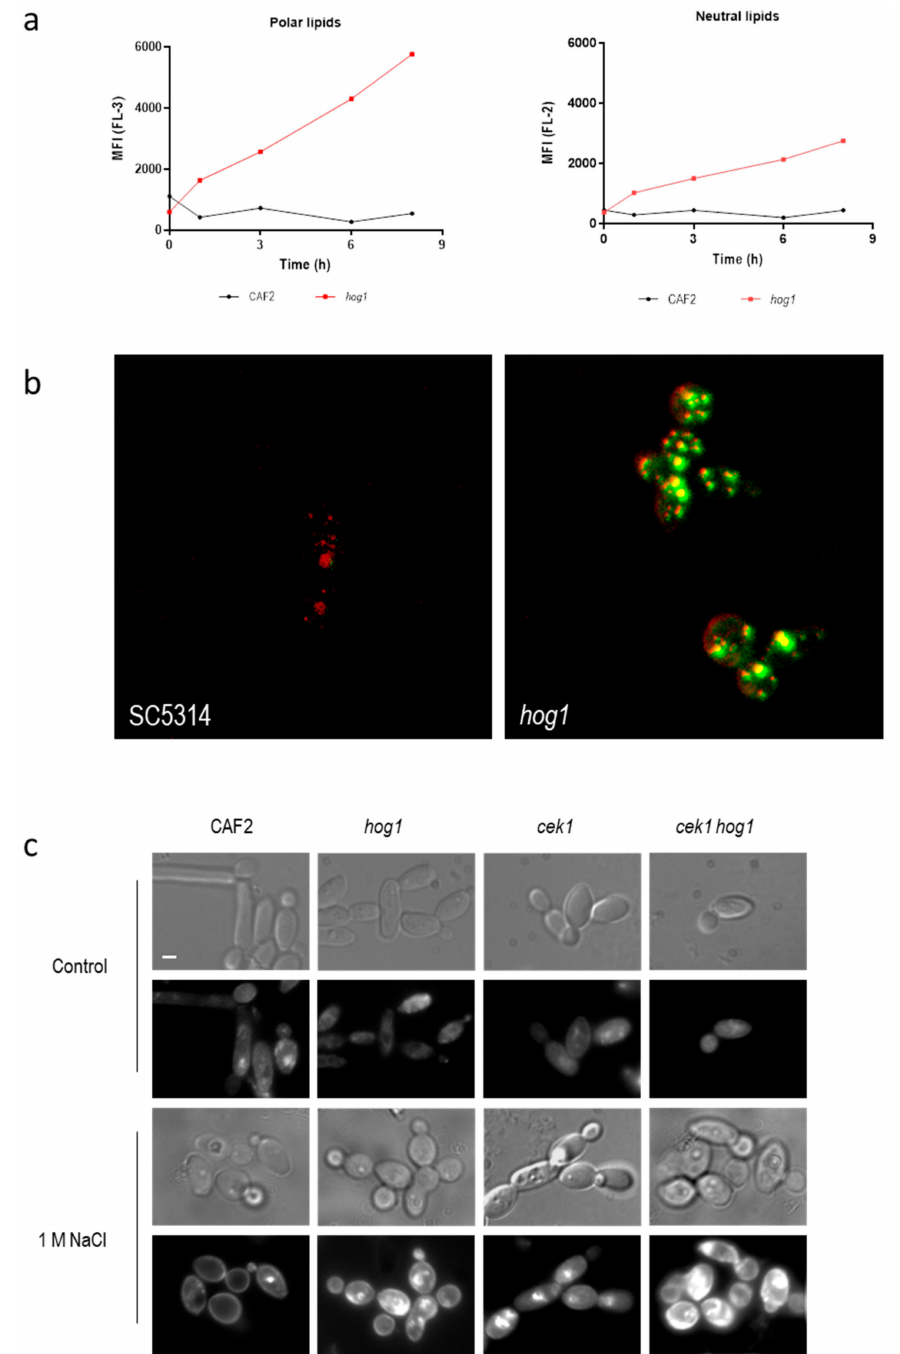
Figure 2. Detection of intracellular lipids upon hyperosmotic challenge. ( a ) Exponentially growing cells were exposed to 1 M NaCl and stained with Nile Red. Fluorescence in FL-2 and FL-3 channels was quantified and mean fluorescent intensity (MFI) belonging to a standard assay is represented along the time. Fluorescence in FL-3 correlates with polar lipid quantification (left panel) while fluorescence of FL-2 correlates with neutral lipids (right panel). ( b ) Visualization of wild type and hog1 mutant cells exposed to 1 M NaCl and stained with Nile Red with a confocal microscope. Red and green fluorescence is shown (co-localization is seen in yellow). ( c ) Detection of ergosterol by filipin stain. C. albicans cells growing in YPD (control) or YPD supplemented with 1 M NaCl for 24 h were stained with filipin (10 µ g / mL for 10 7 cells) and observed under phase contrast microscopy (odd rows) or fluorescence microscopy (pair rows). Bars, 1 µ